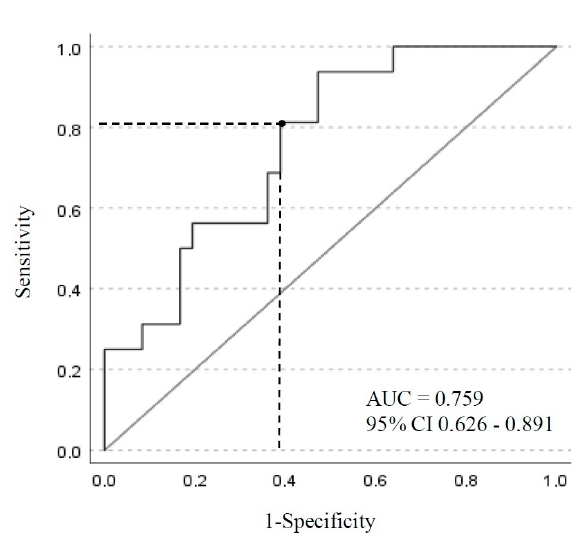
Figure 1. Receiving operating characteristic curve of cefepime plasma concentration with respect to neurotoxicity. AUC, area under the curve; 95% CI, 95% confidence interval.